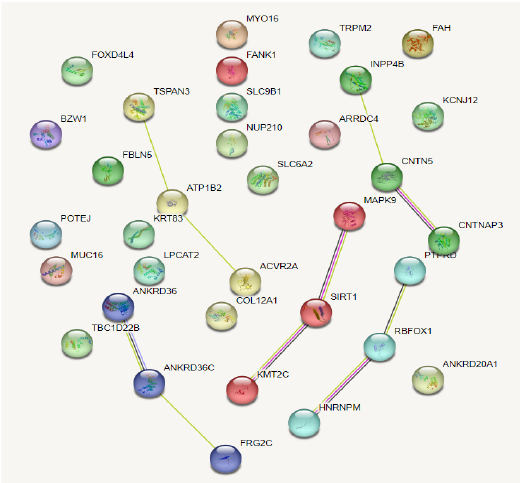
Figure 3. Interaction of and clustering of the protein-coding genes on which deviated frequencies of the SNPs were realized between the sprint/power and endurance groups.